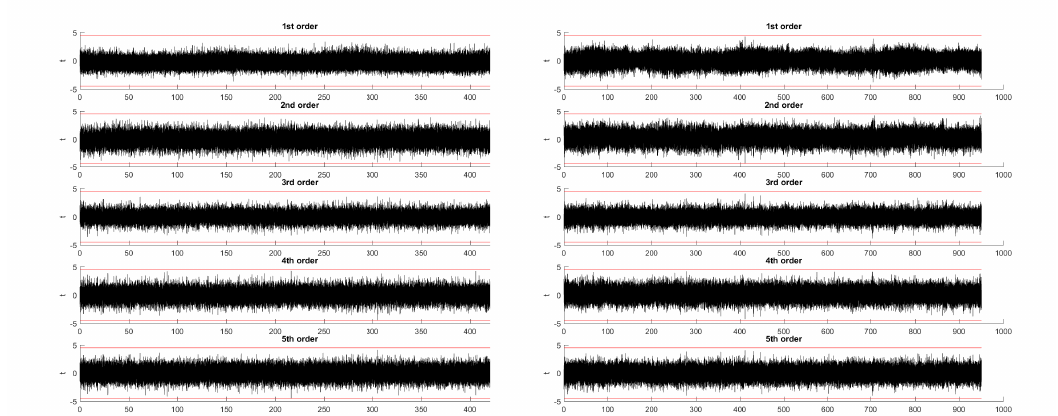
Figure 3: HO t -test for (3,1)- EPMult and (5,2)- EPMult with Exp-Log GF(2 8 ) multiplication using 250.000 traces.